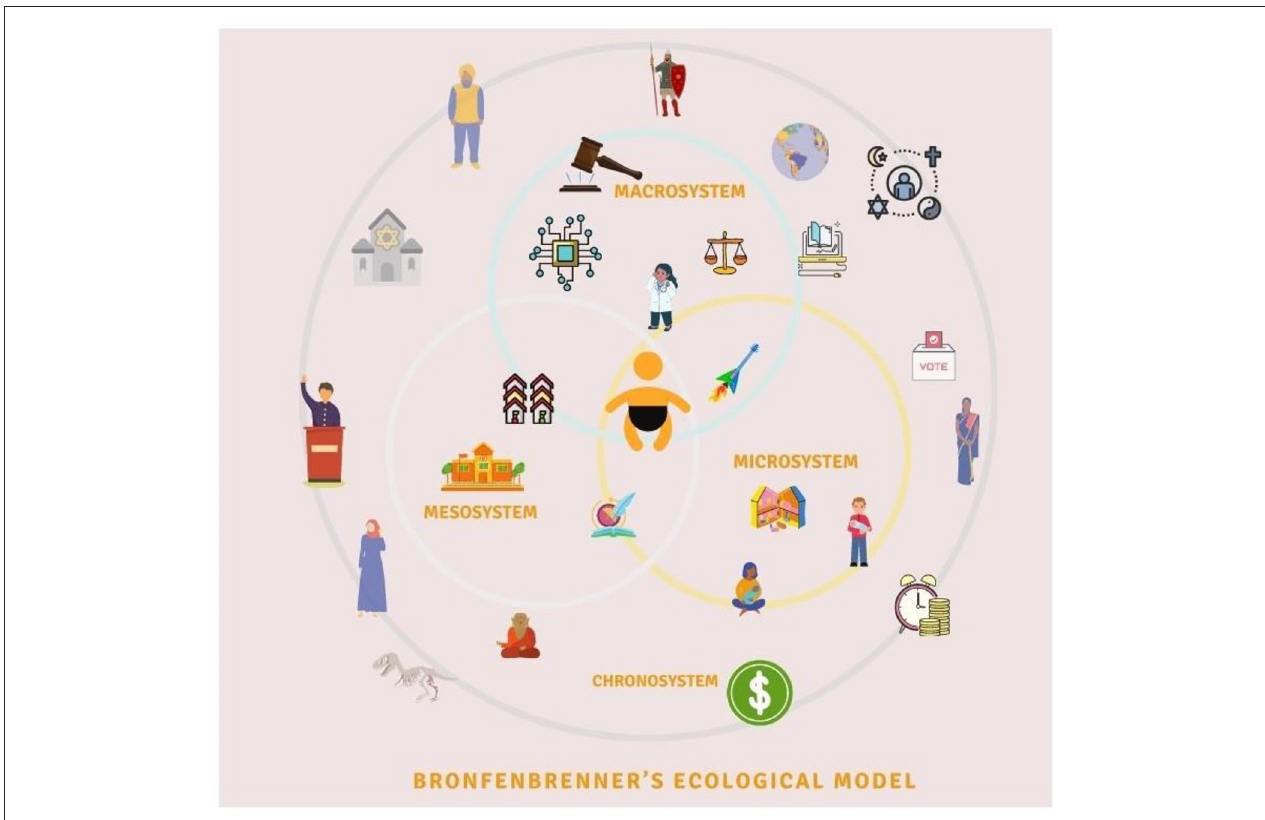
FIGURE 1 | Bronfenbrenner’s bio-ecological systems and their interactions with childhood